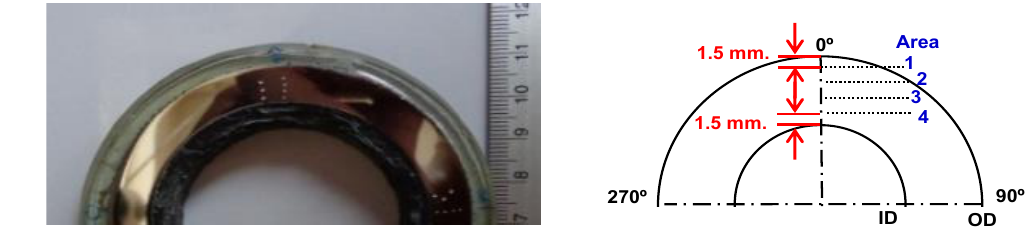
Figure 2. The location on the cross section of tube specimen for micro-hardness testing.